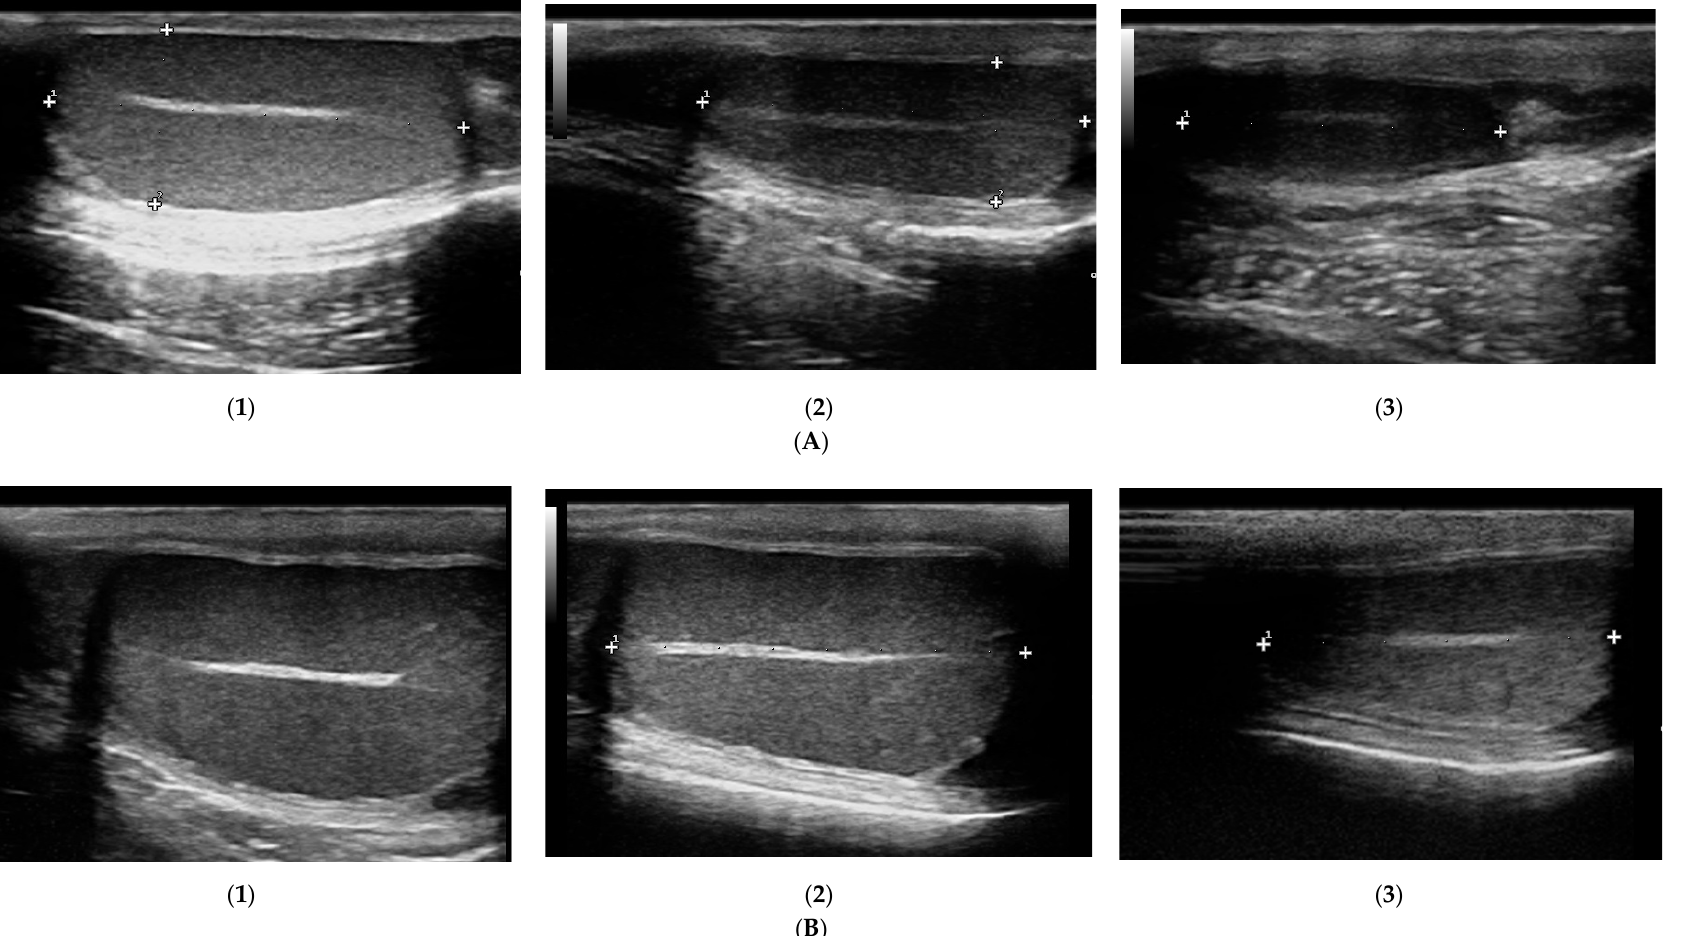
Figure 6. Changes in B-mode testicular imaging in dogs receiving deslorelin acetate. Visible progressive disappearance of mediastinum and gradual lowering of tissue echogenicity. ( A ) and ( B )— patients form Study Group III, examined on ( 1 )— day 0; ( 2 )—week 8; ( 3 )—week 24.